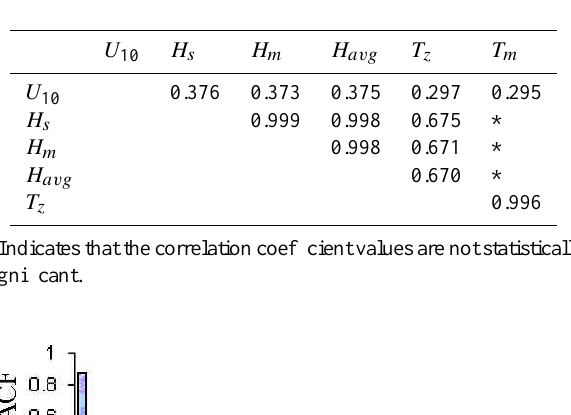
Figur7. Hourly time series significant wave height (Hs), maximum wave height (Hm), wave period corresponding to Hm(Tm) and zero crossing period (Tz),.